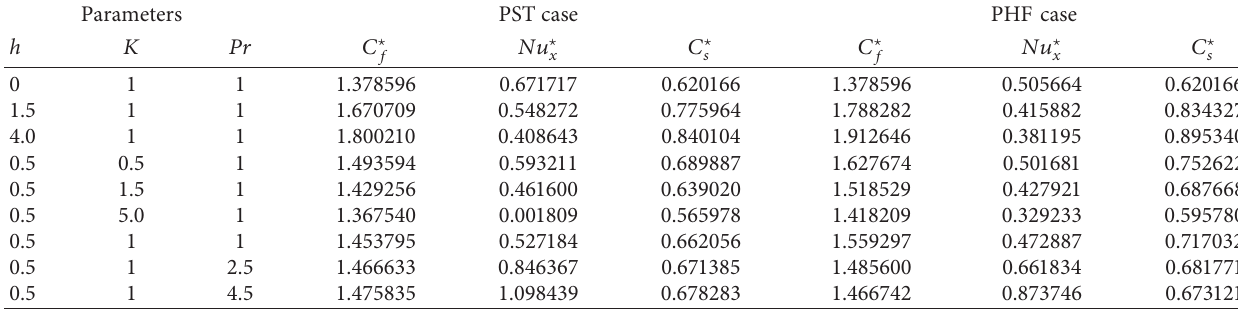
Nu ⋆ C ⋆ x , and s for variations in f ,